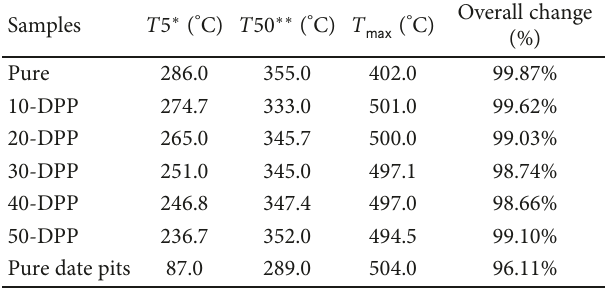
Table 3: Decomposition temperature of the composites.